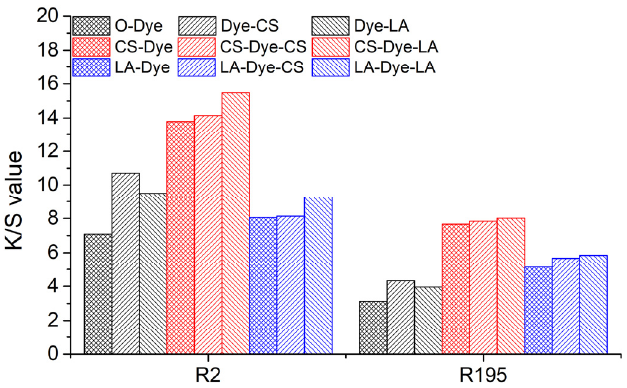
Figure 7. K/S values of the original, pre-mercerized, and post-mercerized woven cotton fabrics dyed with R2 and R195 dyes. Table 4. T % values and K/S values of the original and pre-mercerized woven cotton